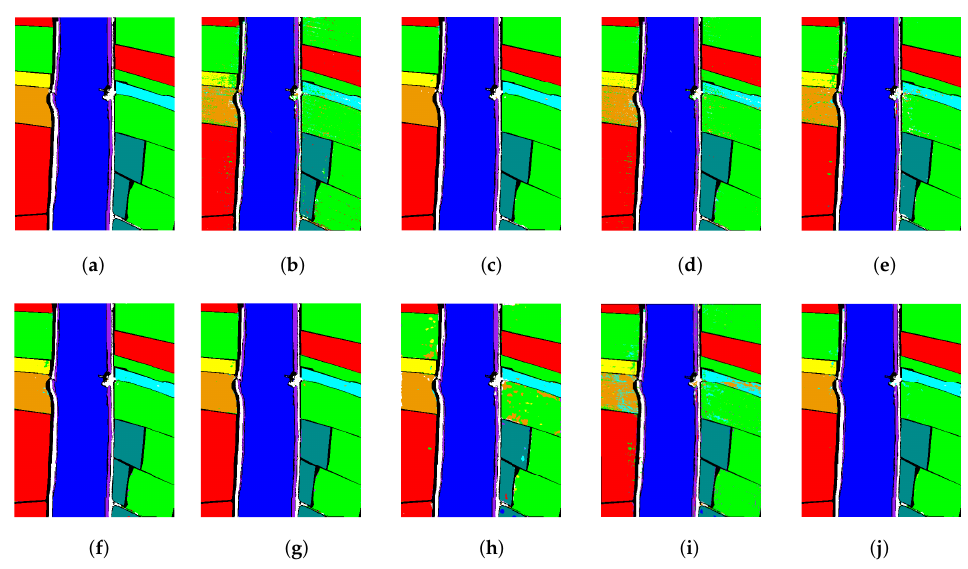
Figure 10. Classification results of ground truth and comparison methods for the LK dataset.